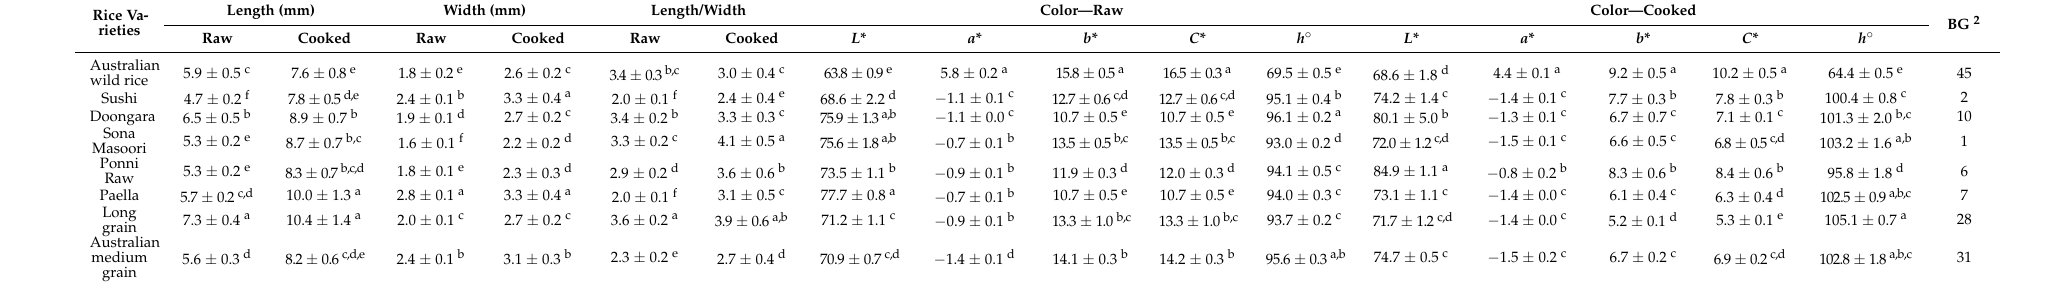
Table 2. Details of physical properties of rice grains 1 .